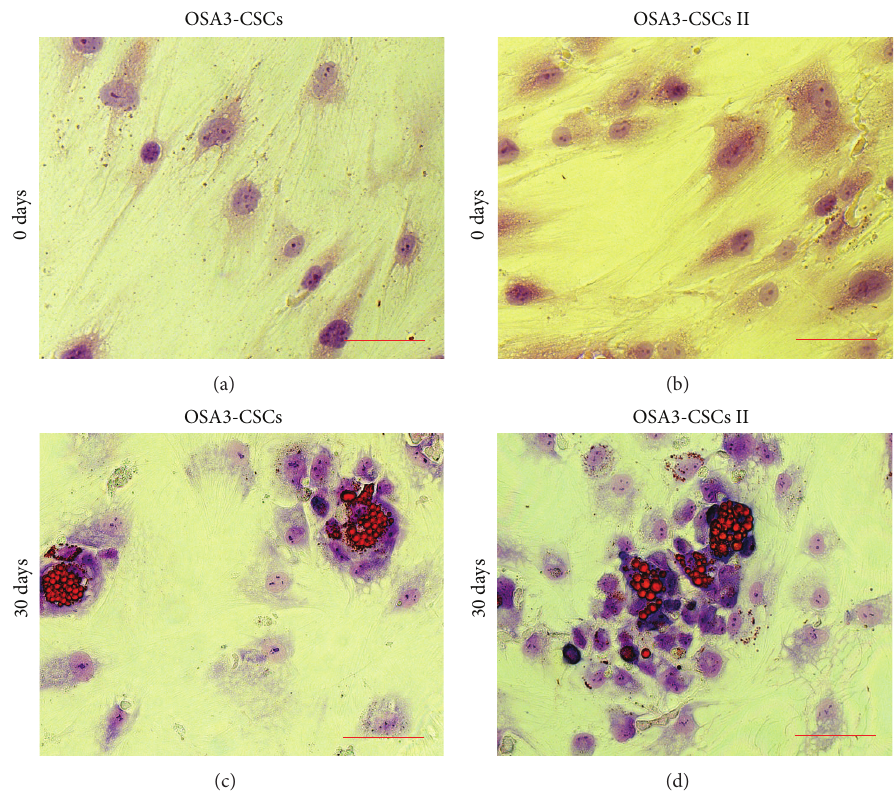
Figure 16: Adipogenic differentiation assay. Adipogenic differentiation at 0 days (a-b) and after 14 days (c-d) of induction by cytochemical staining with Oil Red O. In red the lipid vesicles and in blue/violet the nuclei, which have been counterstained by hematoxylin. Observation in brightfield. Original magnifications: 40x. Bar size: 100 𝜇 m.